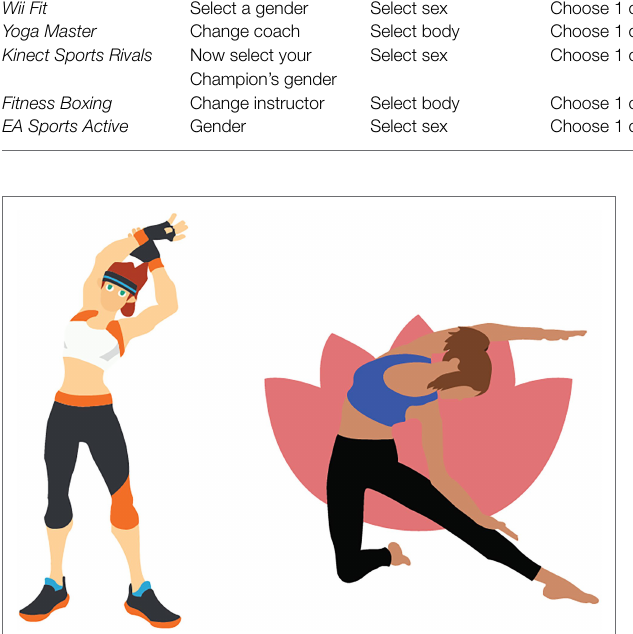
FIGURE 2 | Depiction comparing the female avatar bodies available in Ring Fit Adventure and Yoga Master